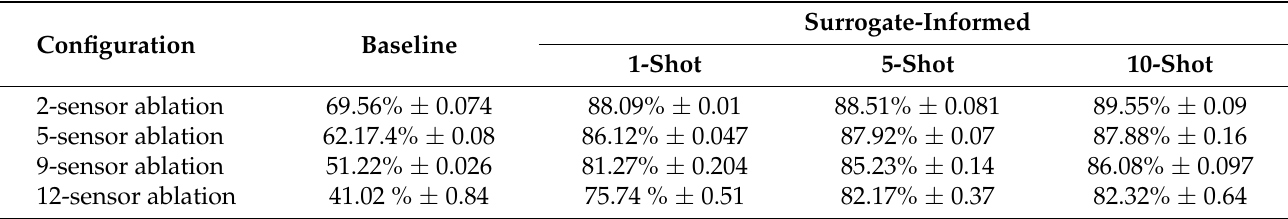
Table 6. Few-shot recognition performances on various sensing configurations featuring the ablation of 2, 5, 9, and 12 sensors from the original sensor deployment of the SHL dataset. For reference, the baseline evaluated on the sensor ablation configurations is also